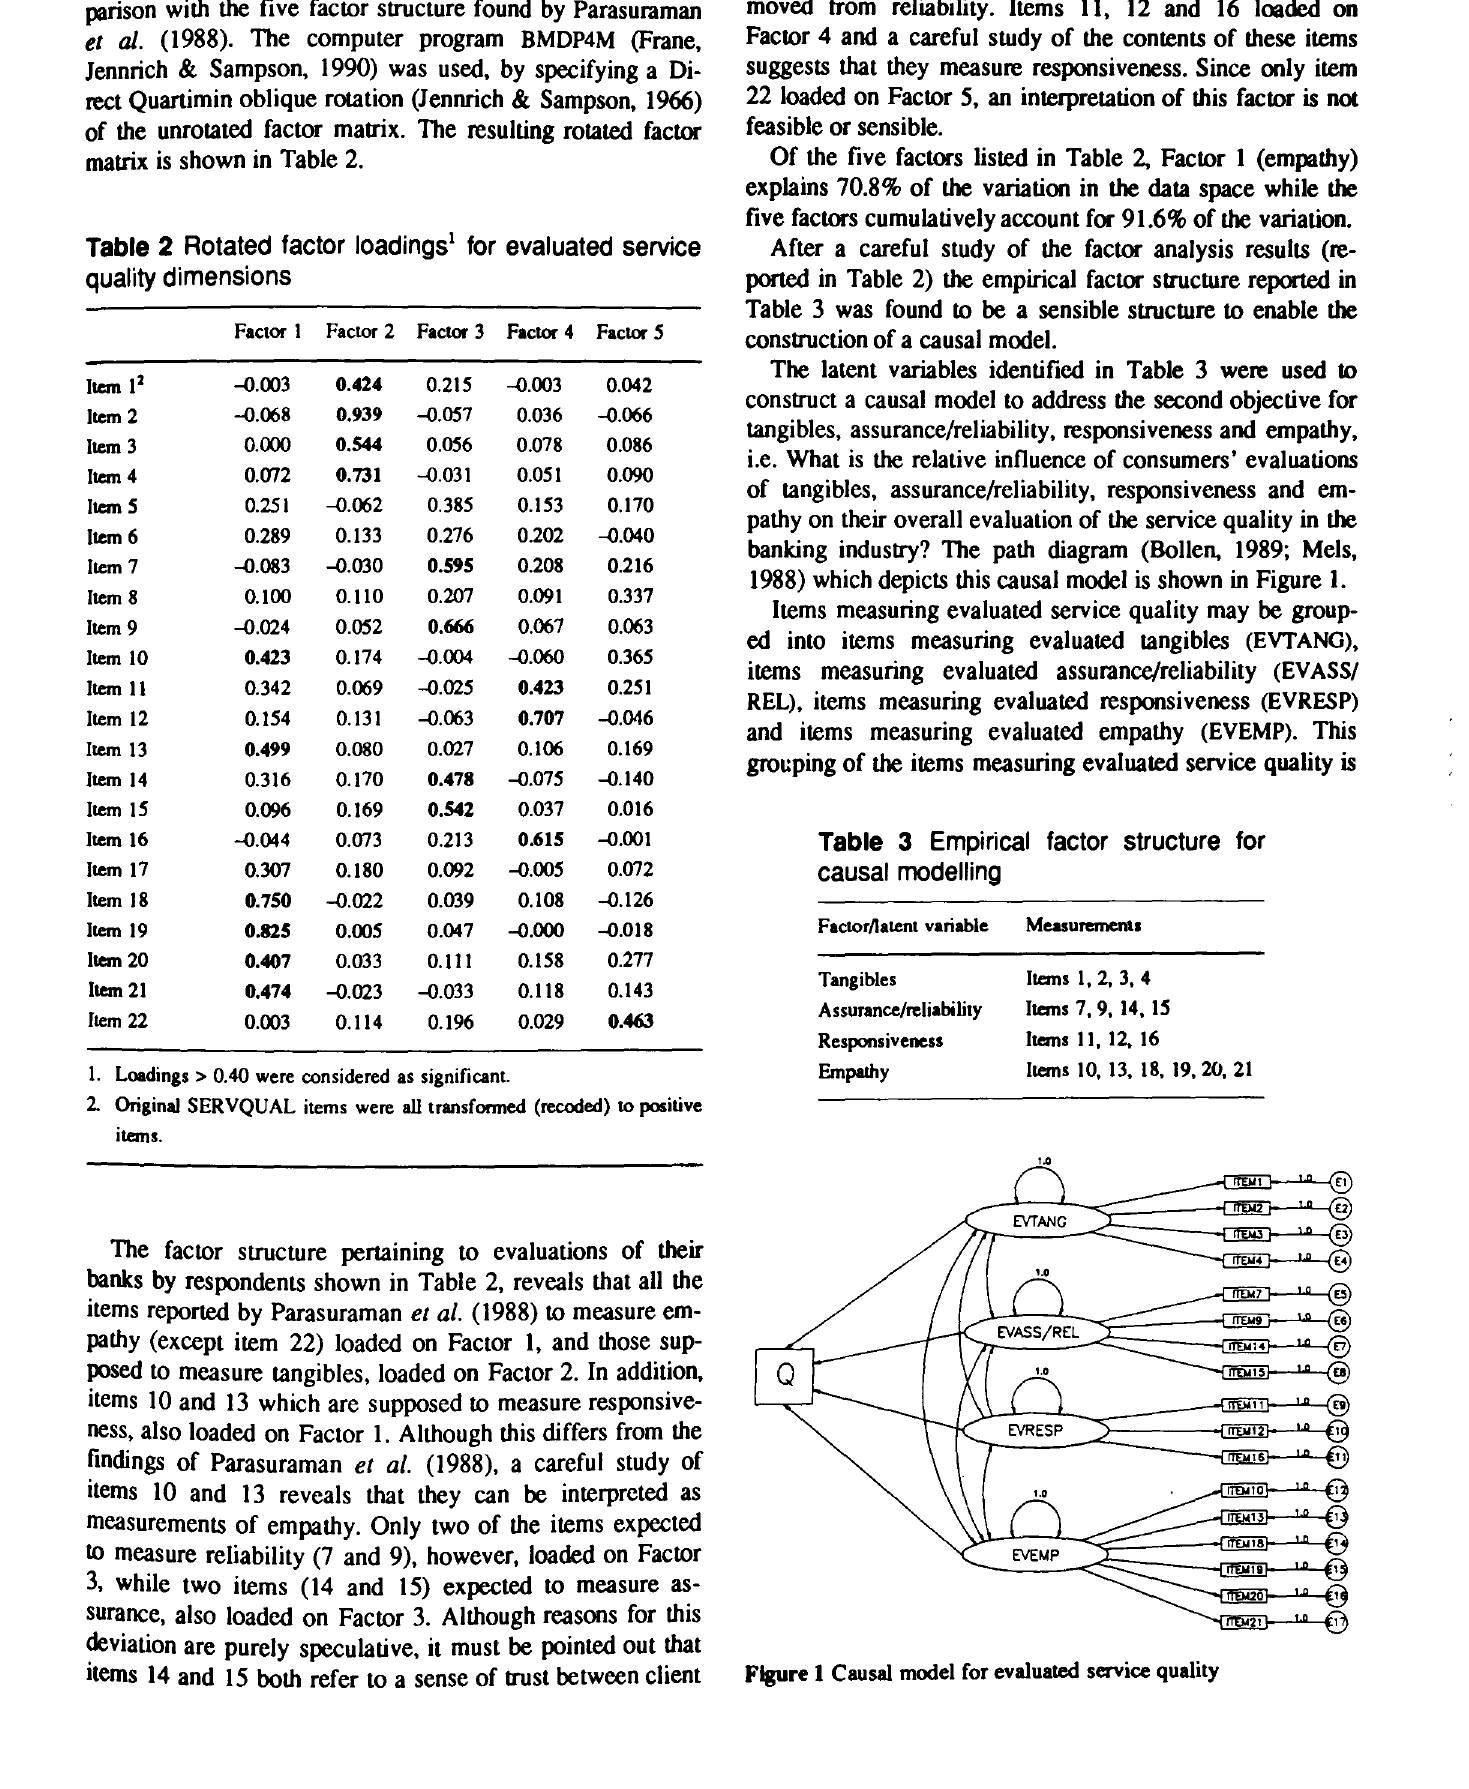
Figure 1 Causal model for evaluated service